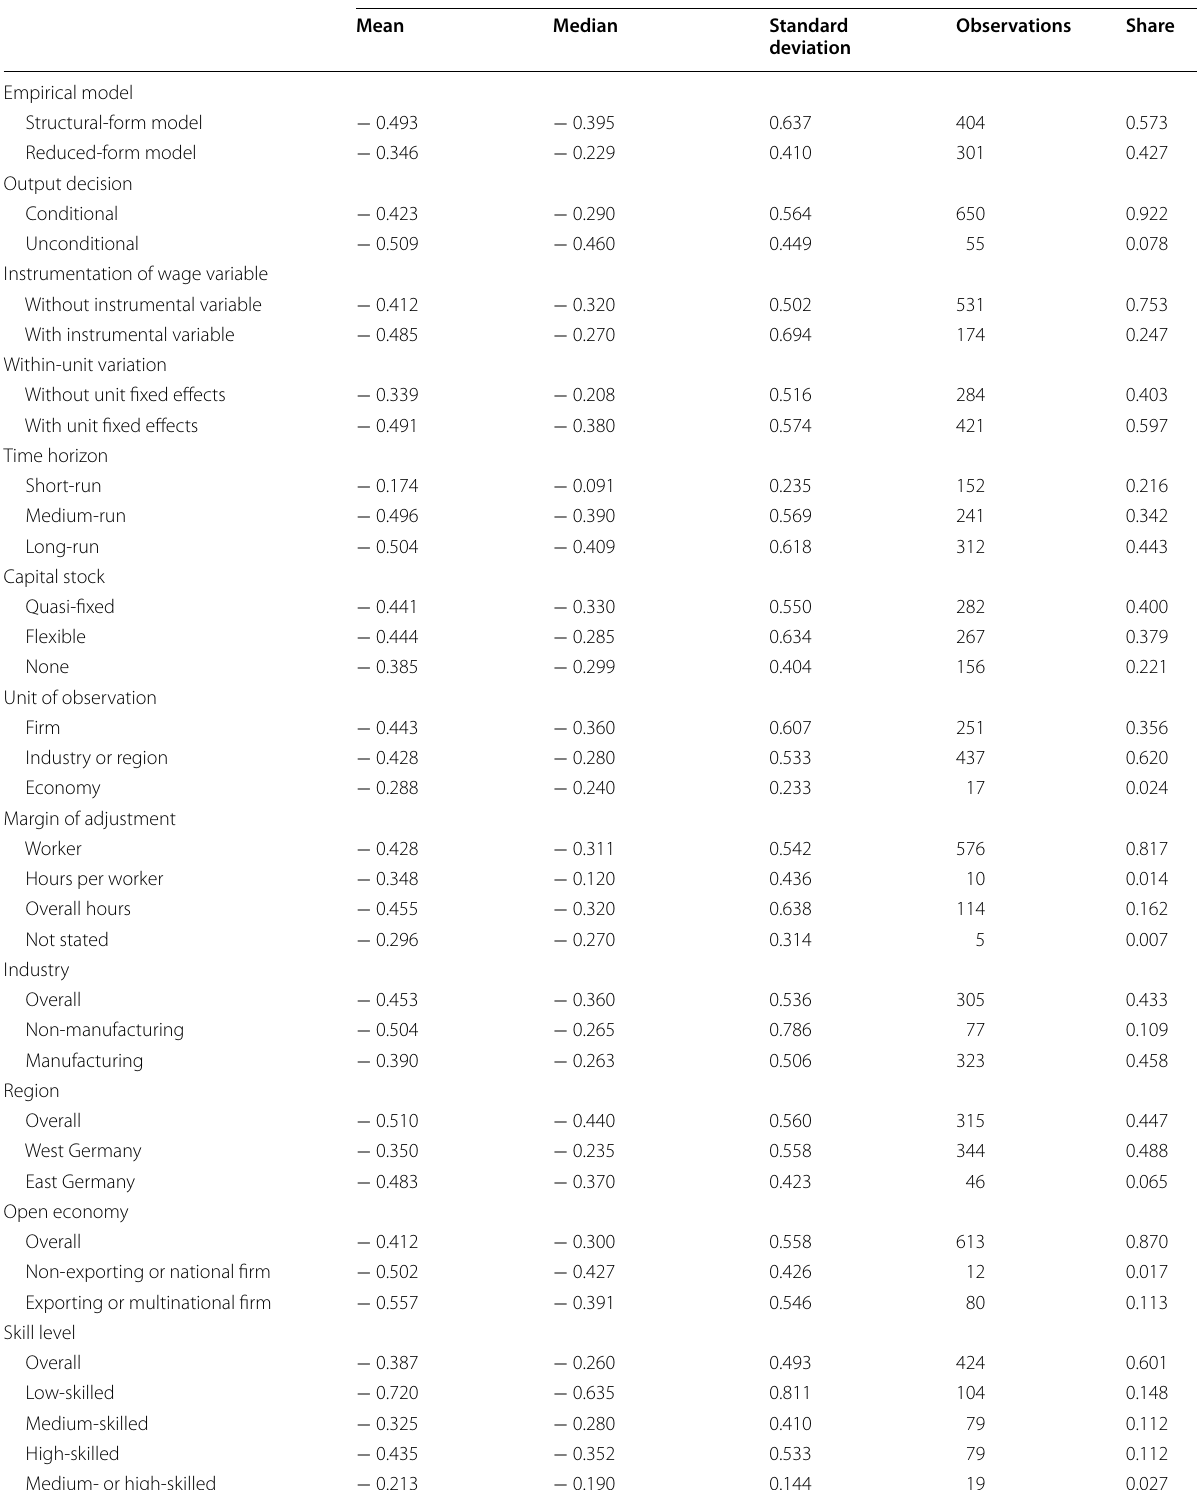
Own-wage elasticity of labor demand Mean Median Standard